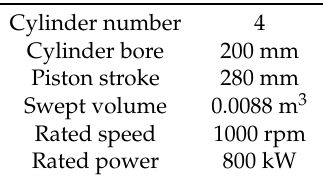
Table 2. WÄRTSILÄ 4L20 engine